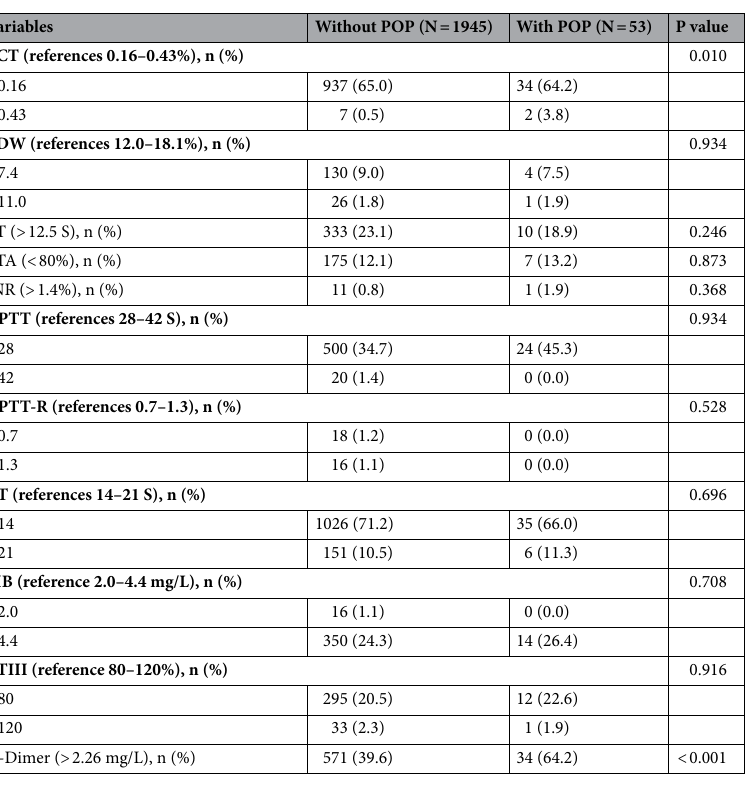
Table 3. Comparison of preoperative laboratory indicators between the two groups. ASA American Society of Anesthesiologists, BMI body mass index, TP total protein, ALB albumin, GLOB globulin, A/G values albumin/globulin, ALT alanine transaminase, AST aspartate aminotransferase, TBIL total bilirubin, DBIL direct bilirubin, IBIL indirect bilirubin, ALP alkaline phosphatase, GGT γ-glutamyl transpeptidase, CHE cholinesterase, TBA total bile acid, HCRP hypersensitive c-reactive protein, LDH lactate dehydrogenase, CREA creatinine, UA uric acid, CA calcium, P phosphorus, Mg magnesium, BNP brain natriuretic peptide, WBC white blood cell, NEUT neutrophile, LYM lymphocyte, MON mononuclear cell, EOS eosinophilic granulocyte, BAS basophilic granulocyte, RBC red blood cell, reference range: female, 3.5–5.0 × 10 12 /L; males, 4.0–